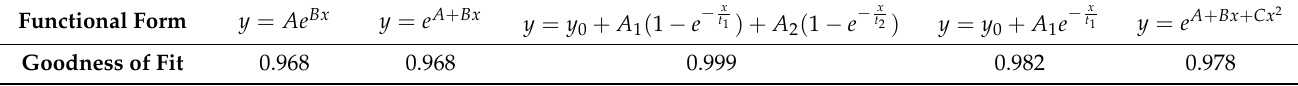
Table 3. Goodness of fit for different fitting